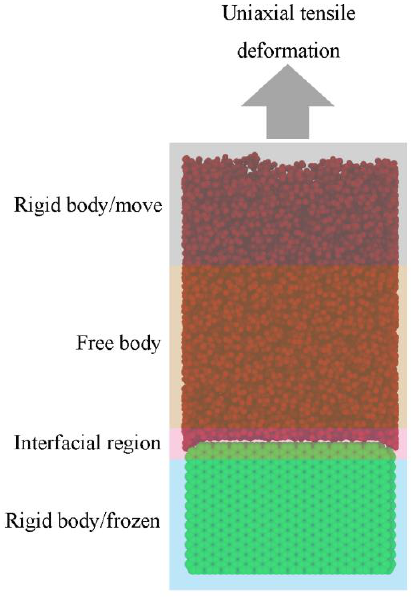
Figure 9. Uniaxial tensile simulation method.